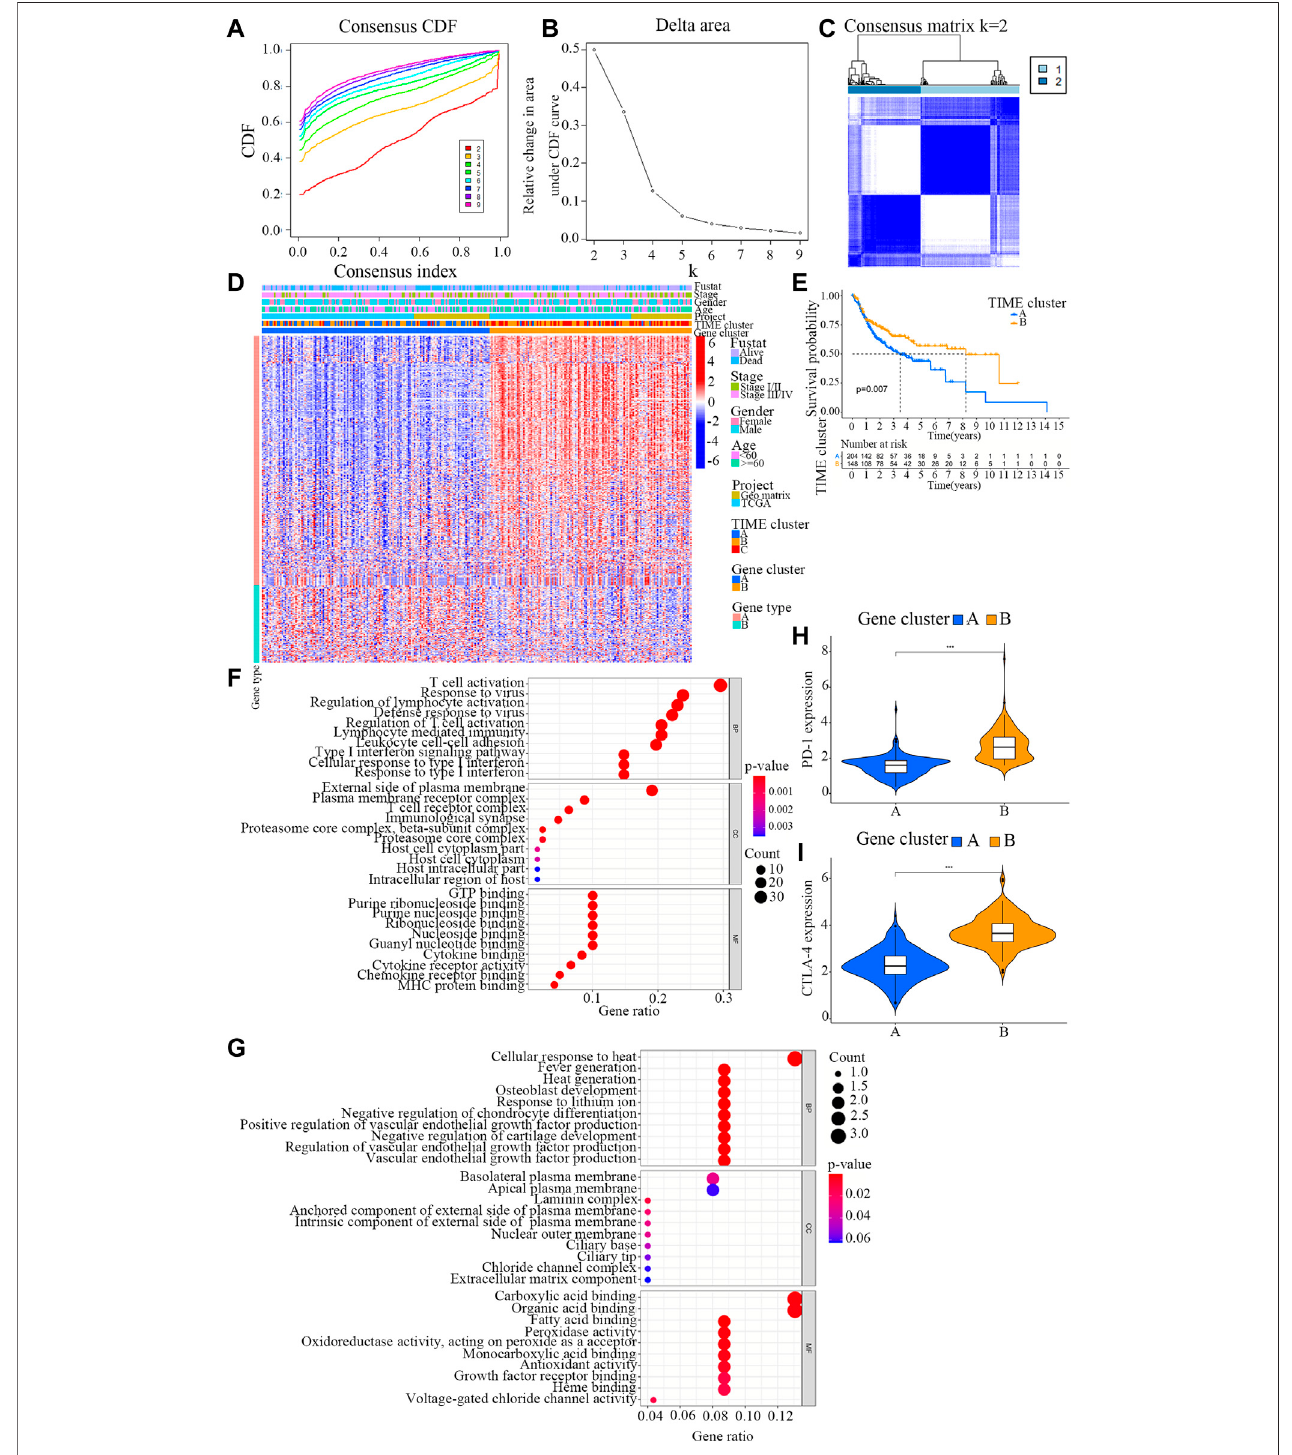
FIGURE 2 | Identi fi cation of immunogenic gene subtypes. (A) Cumulative distribution function curve of each consensus matrix from k = 2 to k = 9. (B) Relative changes in the area under CDF curve based on different k values. (C) Consensus clustering of the 304 specimens derived from TCGA and GEO datasets for k = 2. (D) Unsupervised analysis clustering of common DEGs among three TIME clusters for classifying OSCC patients into Gene clusters (A and B) . (E) Overall survival of OSCC patients in the clusters (A and B) . Log-rank test, p = 0.007. (F) Bubble plot for the functional enrichment analyses of gene cluster (A) . The number of genes annotatedtoaGOtermisindicatedbythexaxis. (G) Bubbleplotforthefunctionalenrichmentanalysesofgenecluster (B) .ThenumberofgenesannotatedtoaGOterm isindicatedbythexaxis. (H) ThedistributionpatternsofTIME-in fi ltratingcellsinthetwogeneclusters.Theimmunescoresofthetwogeneclustersarealsoplotted.* p < 0.05; ** p < 0.01; *** p < 0.001. (I) Difference in the expression levels of PD-1 and CTLA-4 between the two TIME gene clusters.